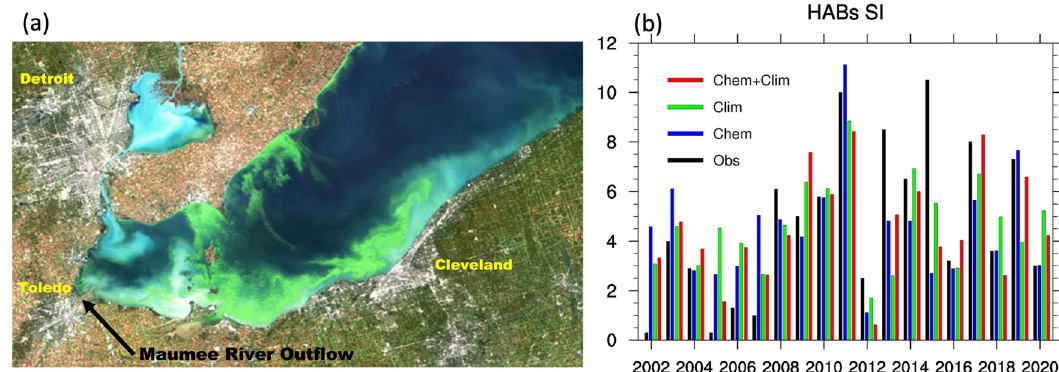
Fig. 1 Satellite image of algal bloom over Lake Erie and seasonal prediction of HABs severity index. a Optical three-band visible image from the Envisat satellite (MERIS_FP) at 300 m resolution showing one of the largest algae blooms from October 2011 extended from Toledo to beyond Cleveland and along the Ontario shore (courtesy of European Space Agency). Data from three visible bands were used each with a bandwidth of 10 nm (442.5, 460, and 665 nm band centers). b HABs severity index (SI) from observation (black bar), prediction using GA-chem model that is based on nutrient loading only (blue bar), prediction using GA-clim model that is based on climate indices only (green bar) and GA-chem-clim that is based on nutrient loading and climate indices (red